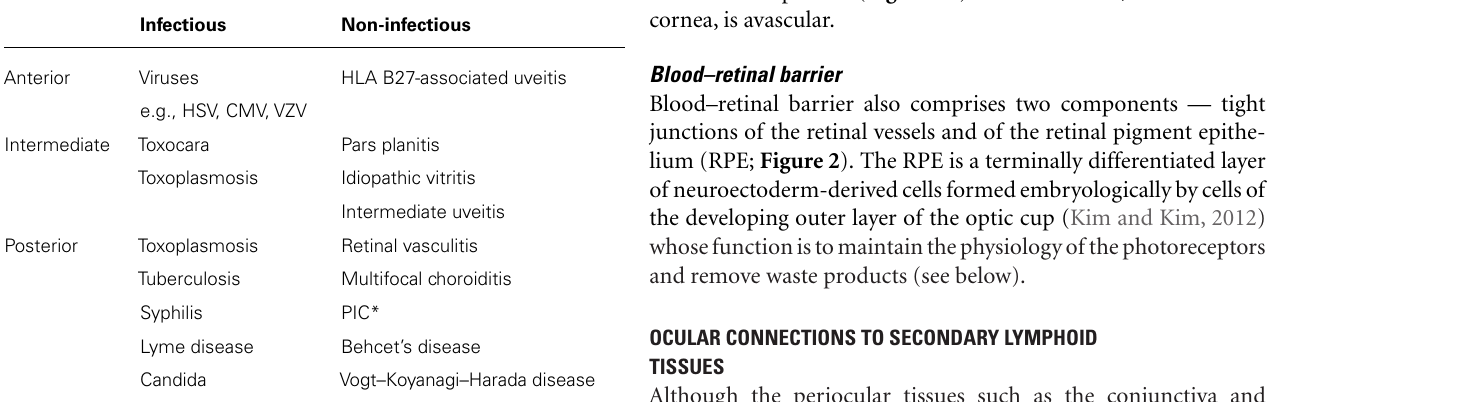
Table 1 | Classification of uveitis (SUN criteria) with some examples. Classification Type of uveitis/uveoretinitis/intraocular inflammation